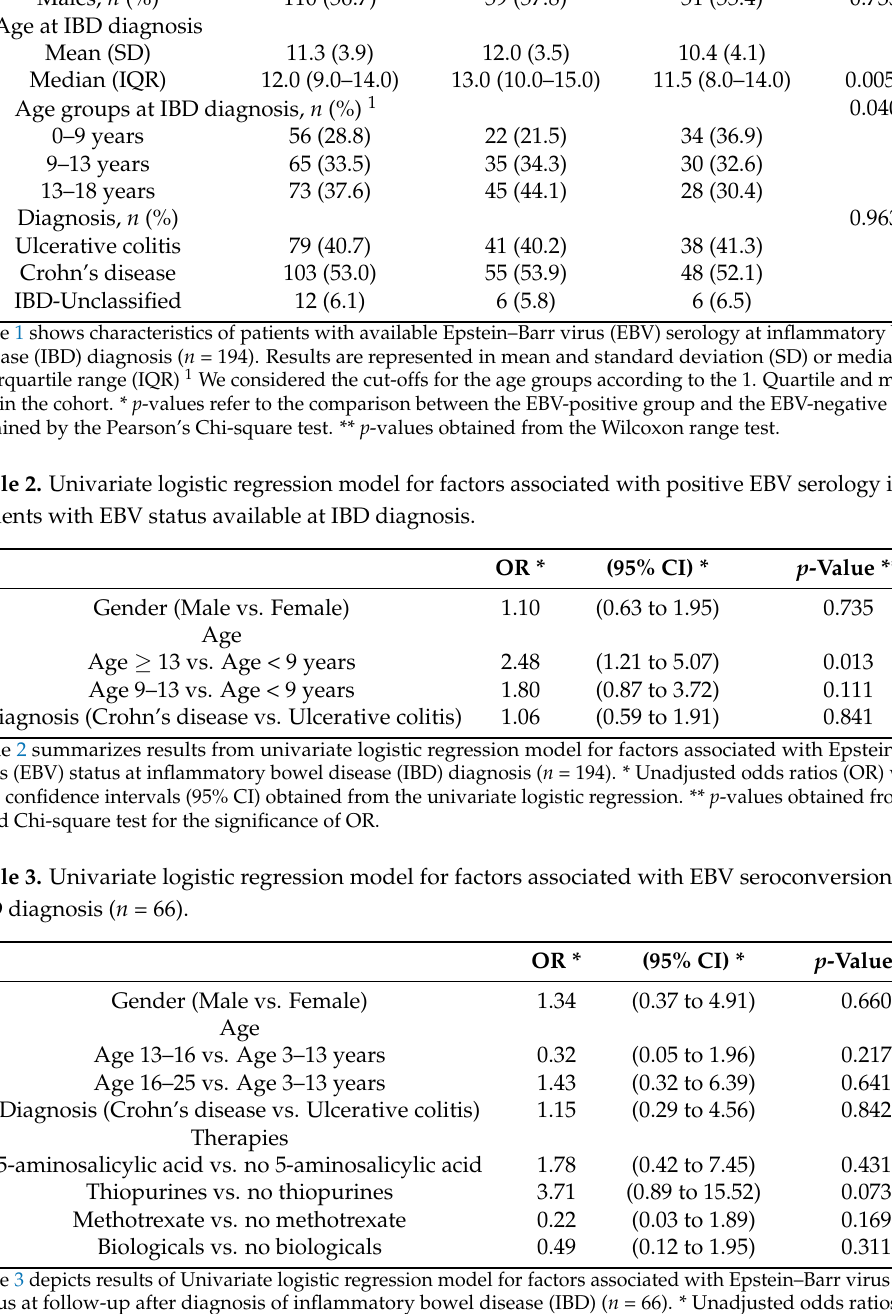
Table 1. Characteristics of patients with available EBV serology at IBD diagnosis ( n = 194).